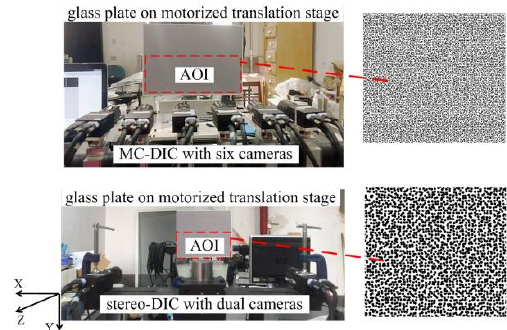
Figure 4. Rigid motion test of a glass plate.